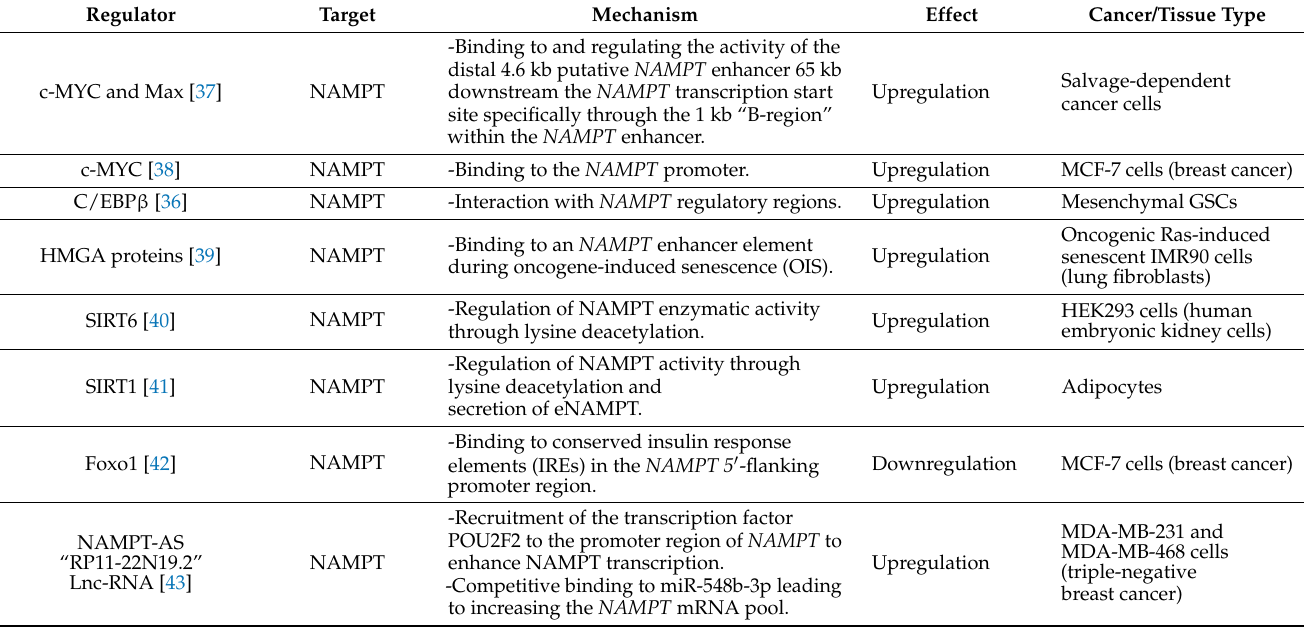
Table 1. Overview of the regulation of the major enzymes involved in NAD biosynthesis.